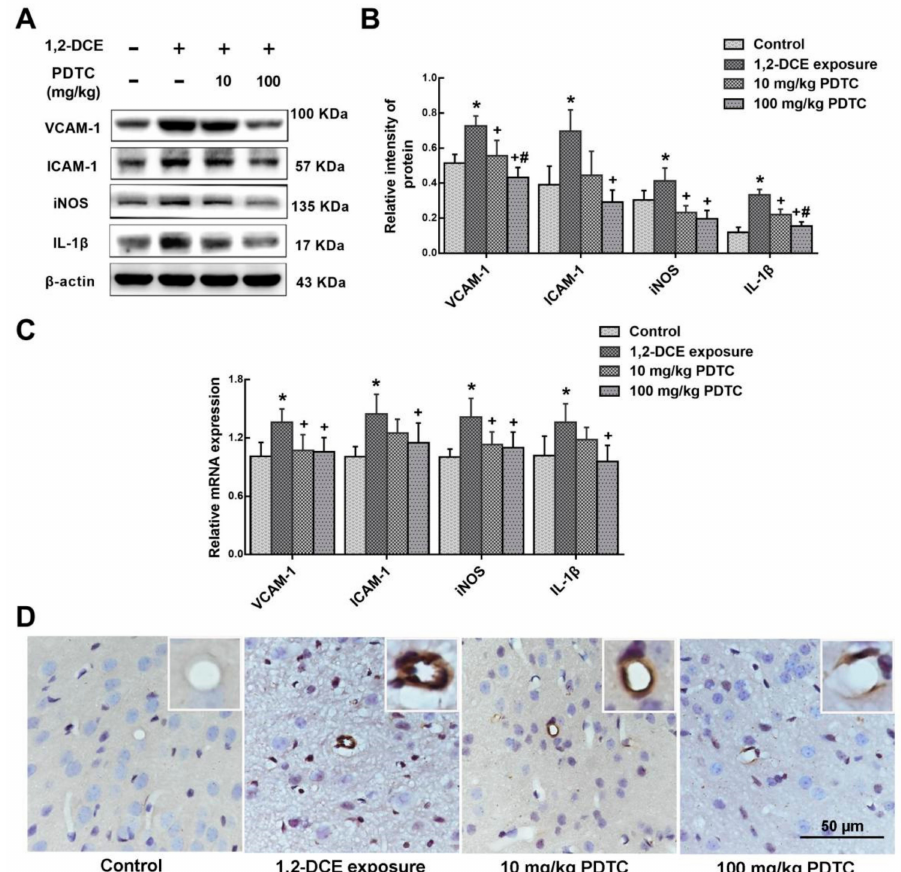
Figure 3. Involvement of NF- κ B in upregulation of VCAM-1, ICAM-1, iNOS, and IL-1 β expression in 1,2-DCE-intoxicated mice. ( A ) Representative images of Western blot analysis. ( B ) Graphs show the densitometric quantitation of VCAM-1, ICAM-1, iNOS, and IL-1 β , which were normalized to the intensity of β -actin. ( C ) Measurement of mRNA levels by real-time RT-PCR. The mRNA levels of VCAM-1, ICAM-1, iNOS, and IL-1 β were normalized to GAPDH and presented as fold change of the control group. ( D ) The photomicrographs of immunocytochemistry represent staining of VCAM-1 in the frontoparietal region of the cerebral cortex, which are representative of five separate experiments and were captured using a Nikon microscope (200 × ). Scale bar represents 50 µ m. Data expressed as mean ± SD are the results of five independent experiments and analyzed by one-way ANOVA. Significant di ff erence is defined as p < 0.05, and *, vs. control group; + , vs. 1,2-DCE poisoned group; # vs. low dose intervention